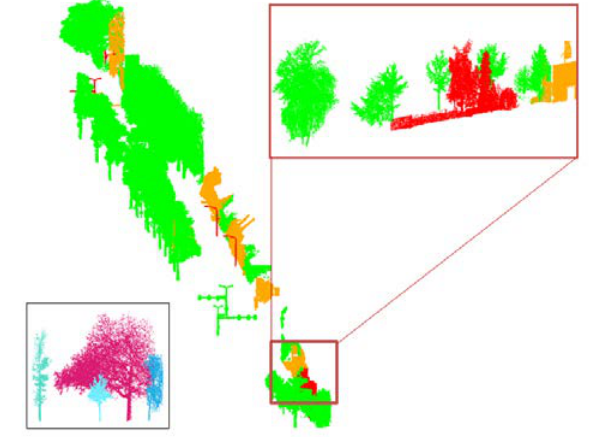
Figure 10 Correlation results on traffic light samples (inset). Components are coloured by correlation: >0.95 (green), >0.9 (orange) and <0.9 (red). Components with correlation lower than 0.85 are not shown.